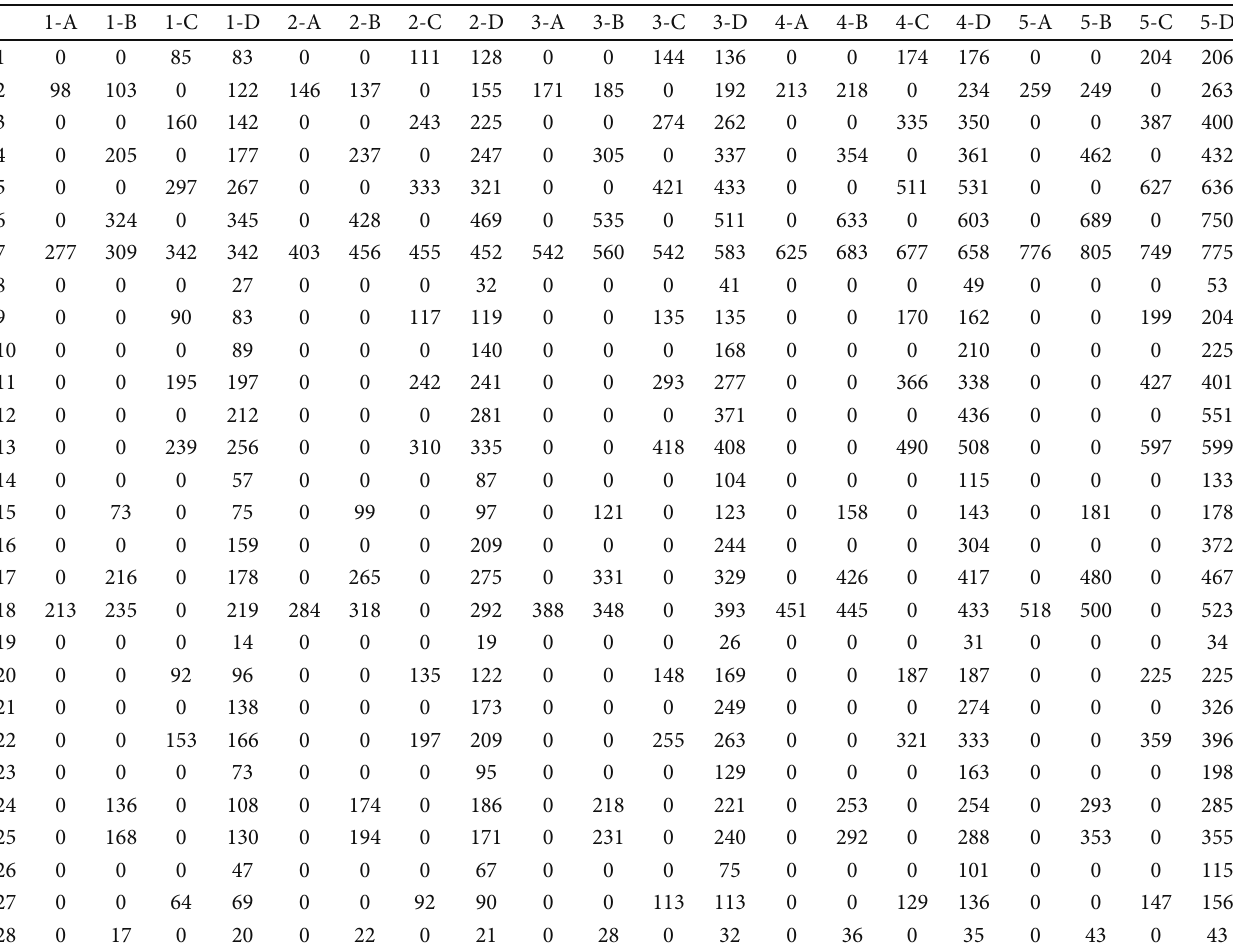
Table 3: Ticket price scheme for con fi dence level α = 0 : 9